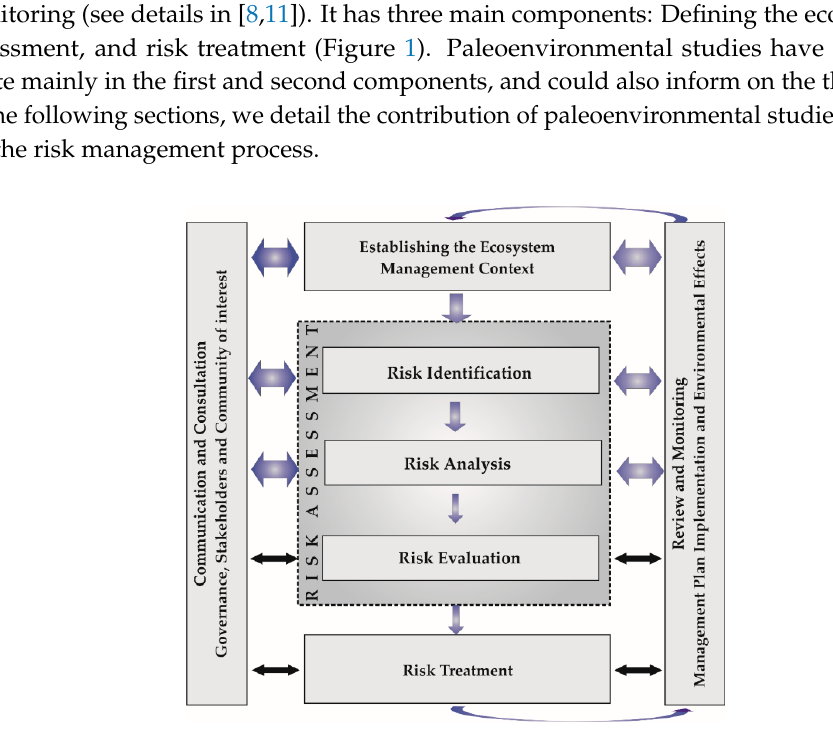
Figure 1. Risk management process for socio-ecological systems modified from [8]. The width of the blue arrow indicates the relative paleoenvironmental contribution in the EBRM. Blue arrows indicate where paleoenvironmental studies have more input; black arrows indicate a modest contribution from paleoenvironmental reconstructions.